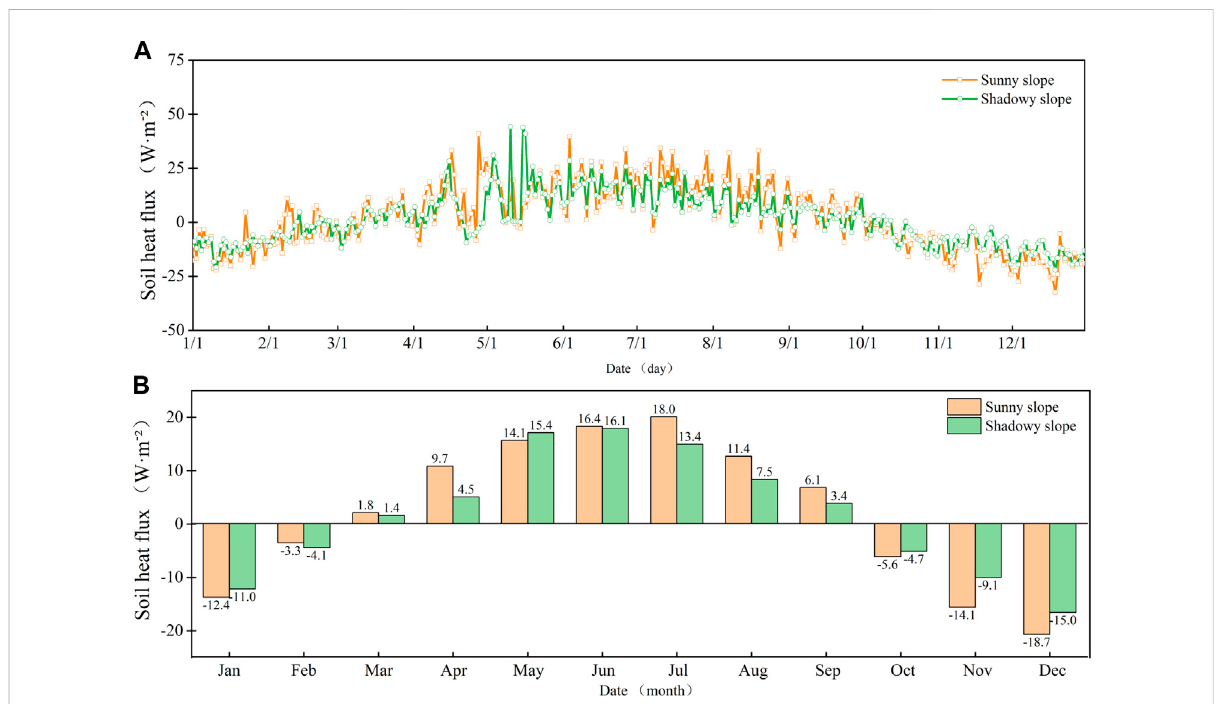
FIGURE 3 Variation of soil heat fl ux of shadowy and sunny slopes. (A) Daily average soil heat fl ux of shadowy and sunny slopes; (B) Monthly average soil heat fl ux of shadowy and sunny slopes.